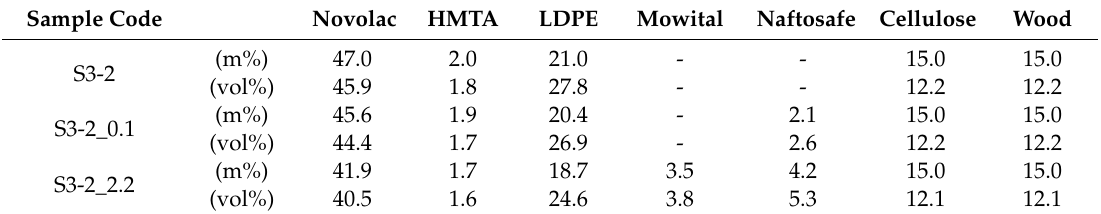
Table 5. List of the formulations prepared for Series 3. Explanation of the nomenclature S3-2_M.N : S3-2 → Series 3, and (novolac + HMTA)–LDPE mass ratio = 70:30 as defined in Series 1; M.N → presence of Mowital (M) and Naftosafe (N), with higher numbers representing larger amounts. Sample Code